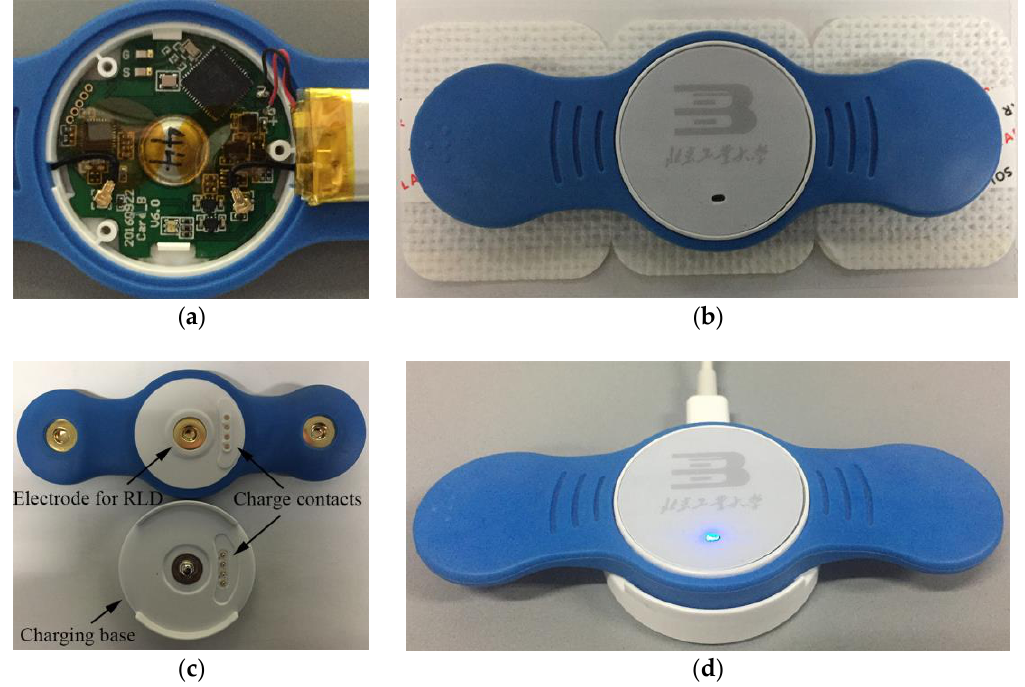
Figure 4. ( a ) The hardware circuit board with lithium-ion battery. ( b ) Front view of the ECG patch device with disposable ECG electrodes. ( c ) The three electrodes of the patch and four charge contacts of the patch and the charging base. (RLD = right leg drive). ( d ) The ECG patch was charging on the charging base.